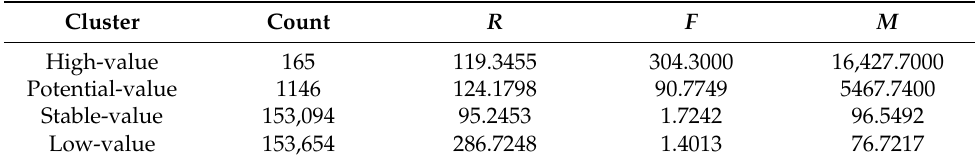
Table 1. Clustering customer by RFM .